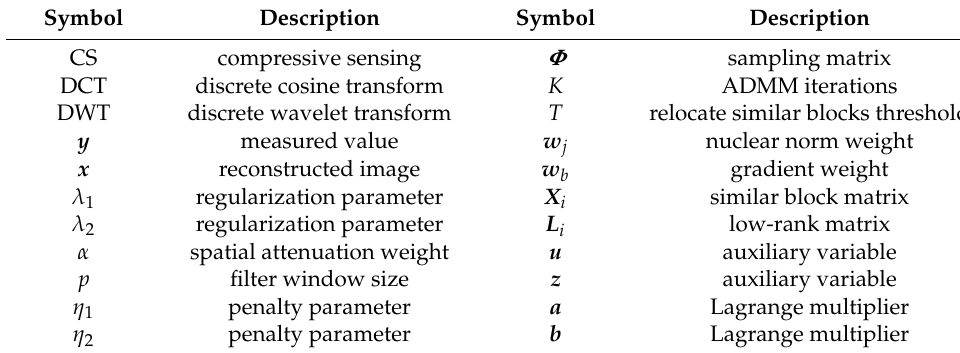
Table A1. Description of relevant symbols in Algorithm